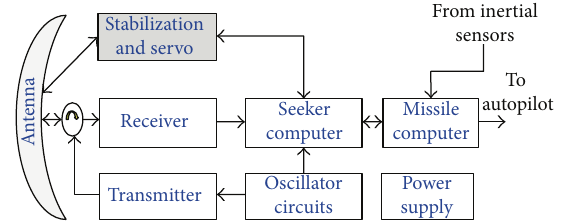
Figure 1: Active radar gimbaled seeker basic